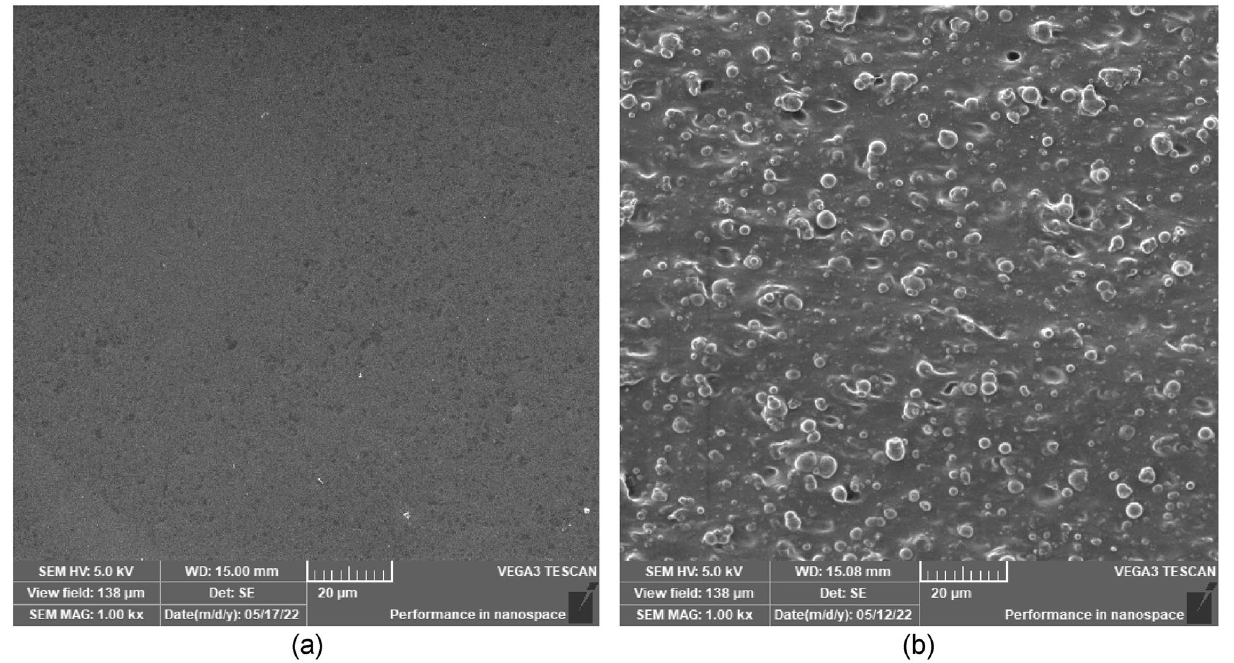
Figure 1. SEM micrographs for ( a ) surface morphology and ( b ) cross-section of MRE sample.